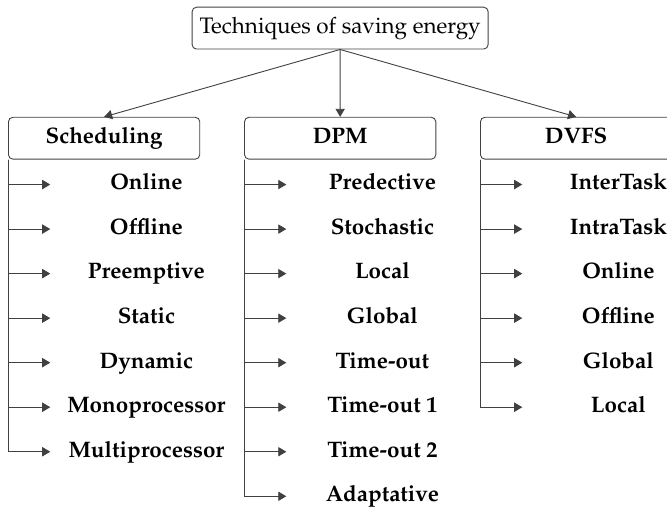
Figure 2. Power Management Taxonomy at CPU